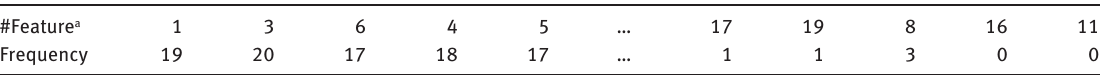
Table 4. Frequency of Selected Features in 20 Pareto Solutions Obtained for the German Data Set.